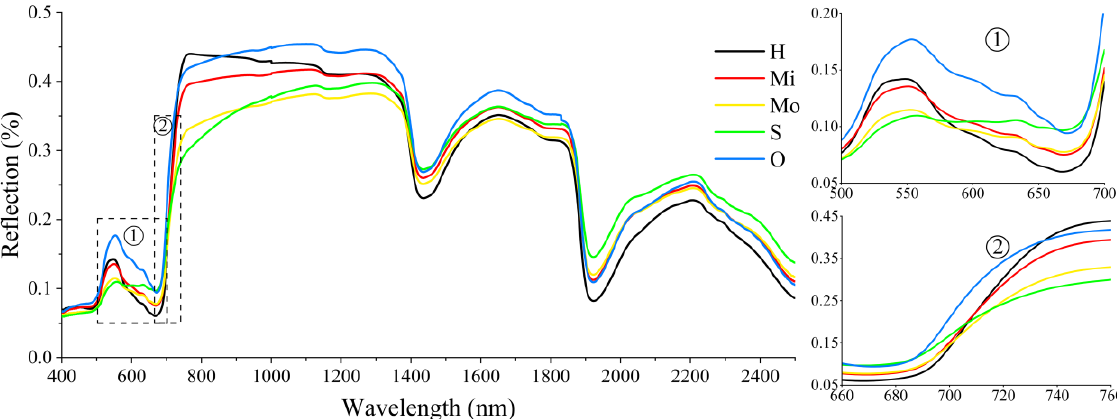
Figure 5. Spectral information for Moso bamboo leaves in different states: ① and ② are local enlargements of the corresponding areas.